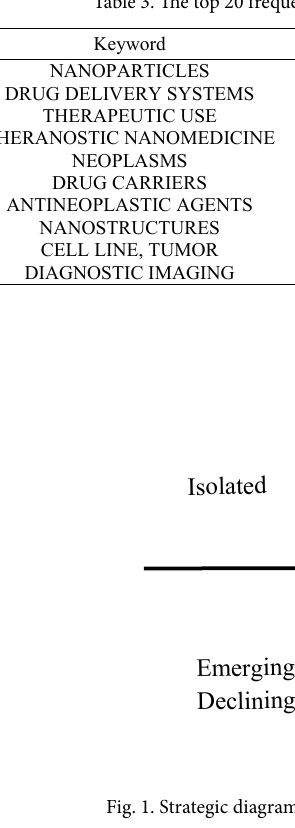
Table 3: The top 20 frequently-used keywords in Nanomedicine area (2009-2018). Table 3. The top 20 frequently-used keywords in Nanomedicine area (2009-2018).